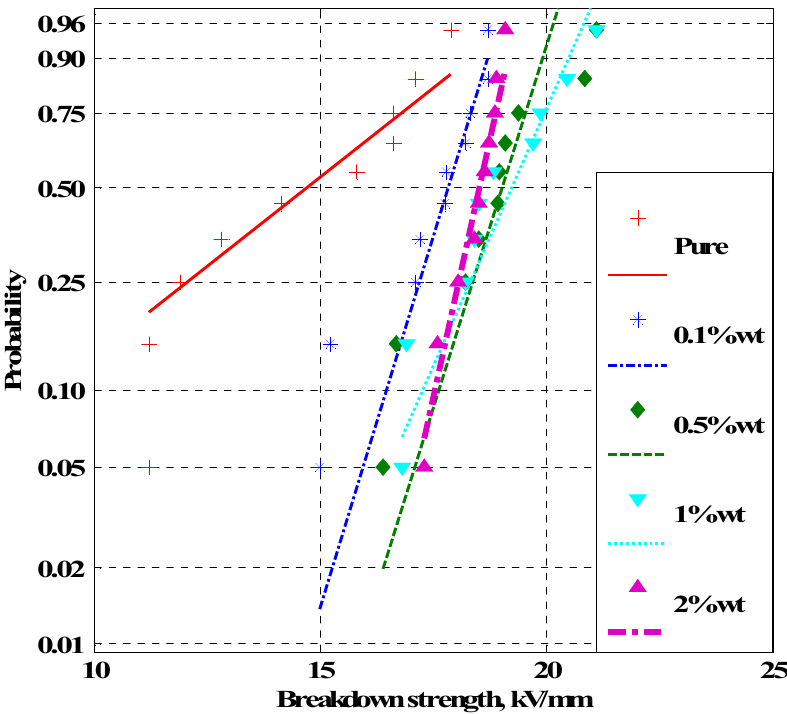
Figure 10. Weibull probability curves for breakdown strength of SiO 2 /silicone rubber nanocomposites.